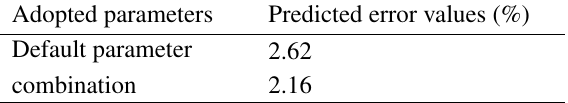
Table 7 Comparison of two parameter